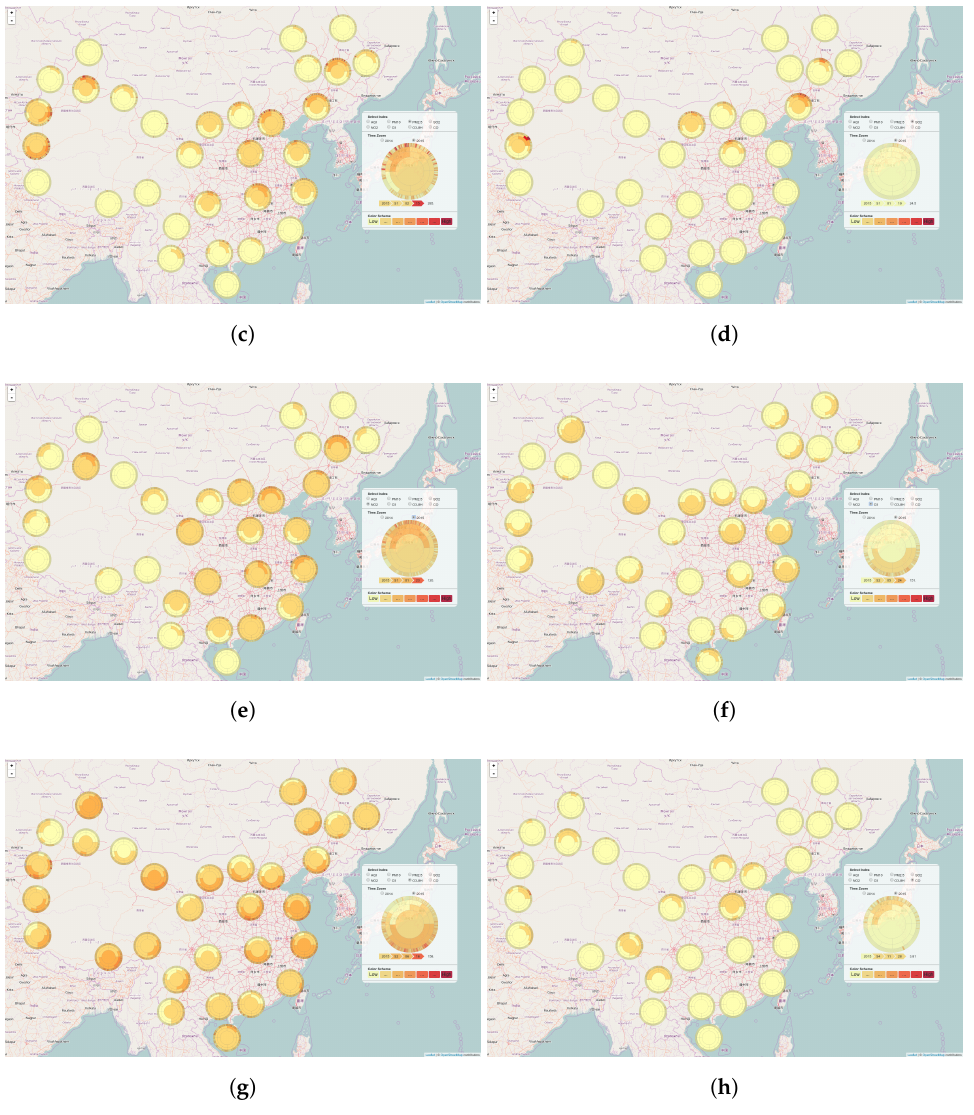
Figure 10. Air quality maps 2015 at OpenStreetMap Zoom Level 5. ( a ) is the AQI map of 2015; ( b )–( g ) are the air pollutants’ concentration map in 2015 for PM10, PM2.5, SO 2 , NO 2 , O 3 and CO respectively. ( a ) AQI map of 2015; ( b ) PM10 concentration map of 2015; ( c ) PM2.5 concentration map of 2015; ( d ) SO 2 concentration map of 2015; ( e ) NO 2 concentration map of 2015; ( f ) O 3 concentration map of 2015; ( g ) O 3 8H concentration map of 2015; ( h ) CO concentration map of